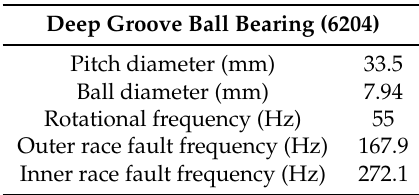
Table 1. Dimensions of the bearings and characteristic fault